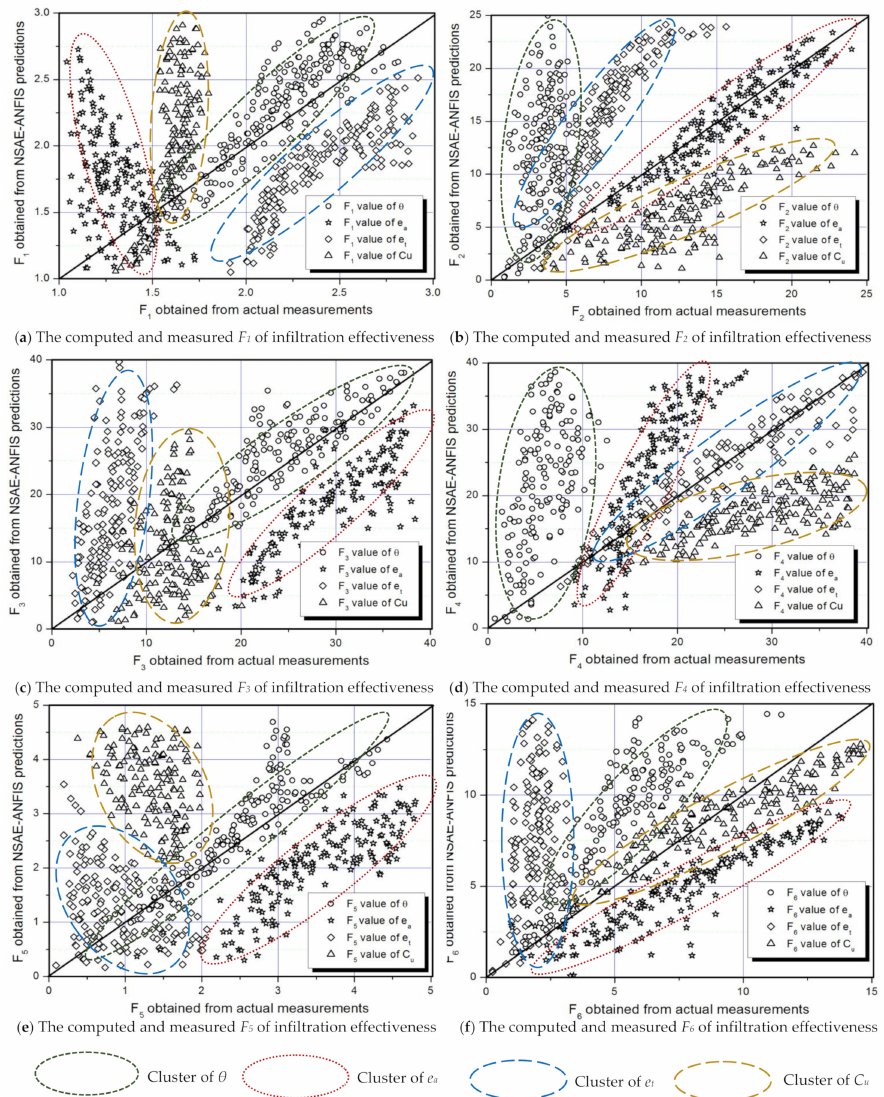
Figure 8. Cluster distribution of F 1 – F 6 used for the prediction evaluation of infiltration effectiveness indexes, where the computed and measured indexes of recursive complexity, functional inclusion, computational compactness, cluster validity, Kullback–Leibler divergence, fuzzy clustering unifor- mity for describing infiltration effectiveness could be